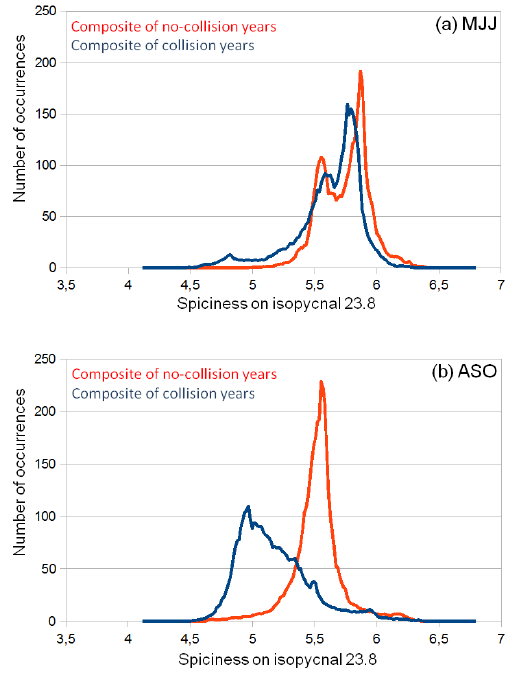
Figure 11. Histograms of spiciness (cid:53) in the GW box for a compos- ite of years with collision (blue) and a composite of years with no collision (red) in simulation S12-1, (a) for the period May to July (MJJ) and (b) the period August to October